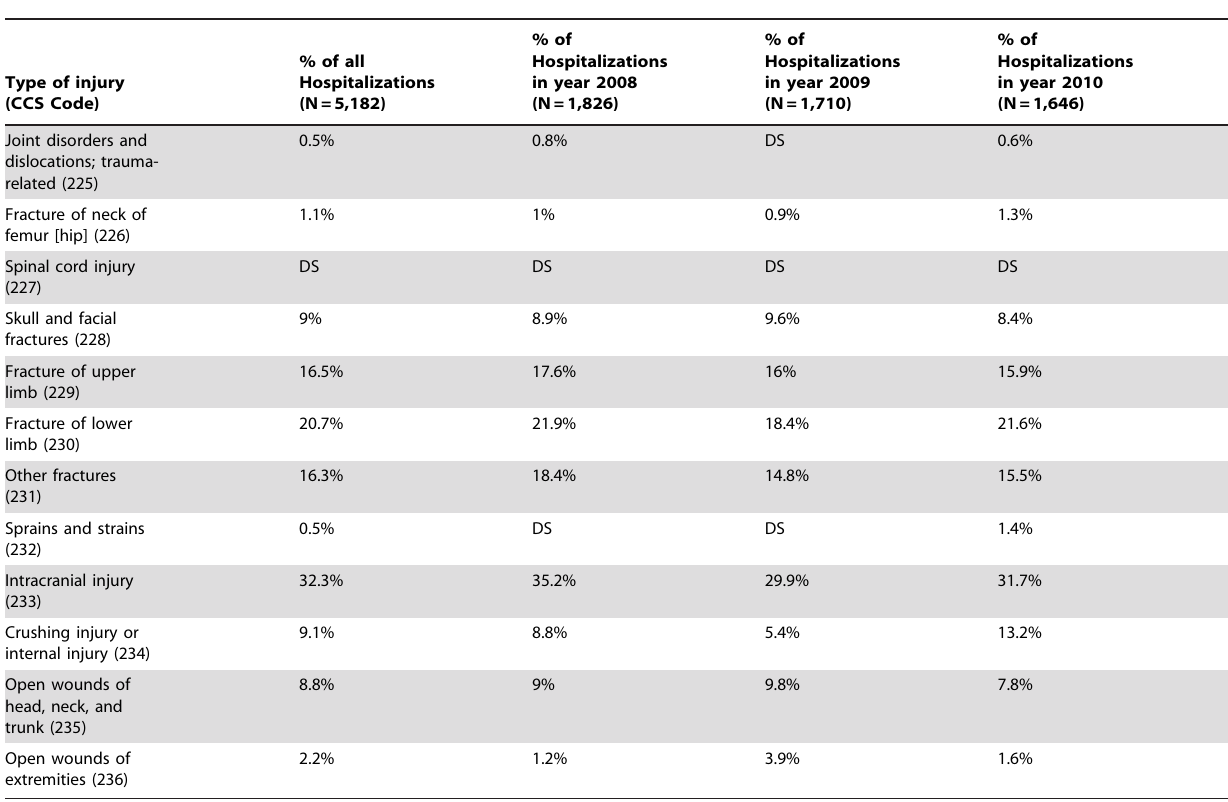
Table 5. Types of Injuries among those